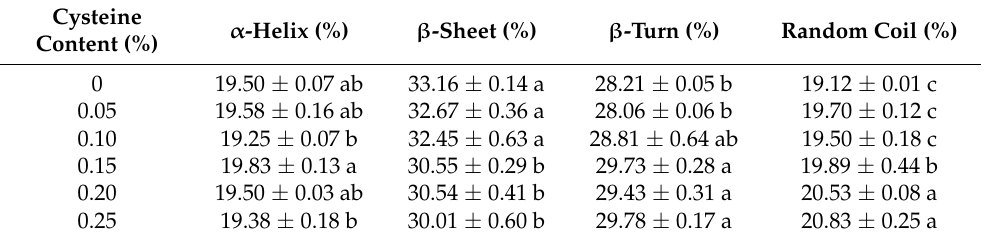
Table 4. Effects of cysteine content on the relative percentage of protein secondary structure of the extrudates.